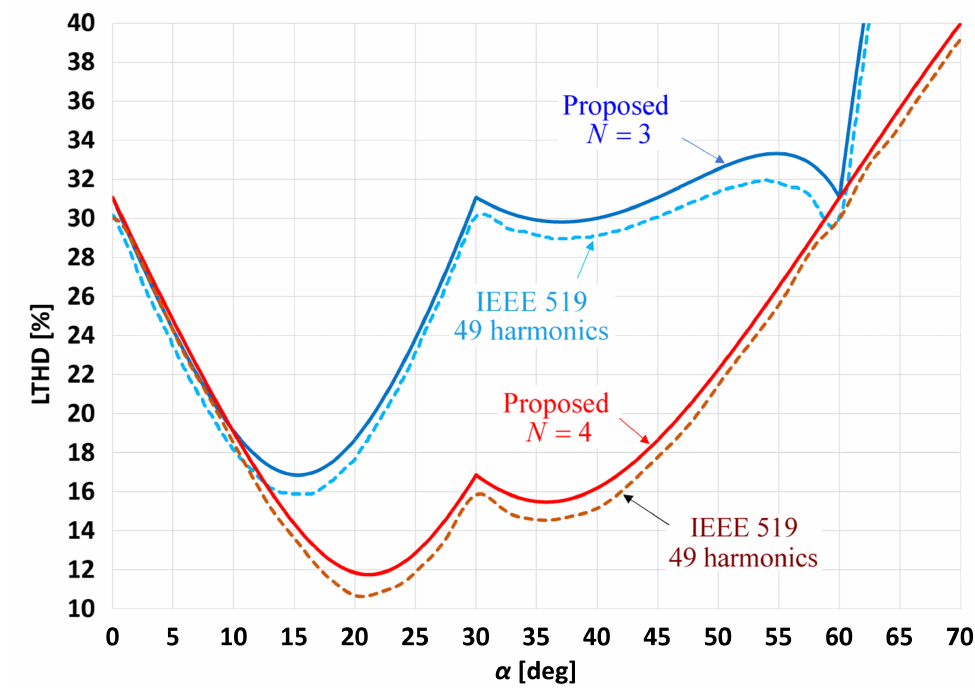
Figure 2. LTHD for N = 3, 4: proposed vs. 49 harmonics (IEEE 519 Std).